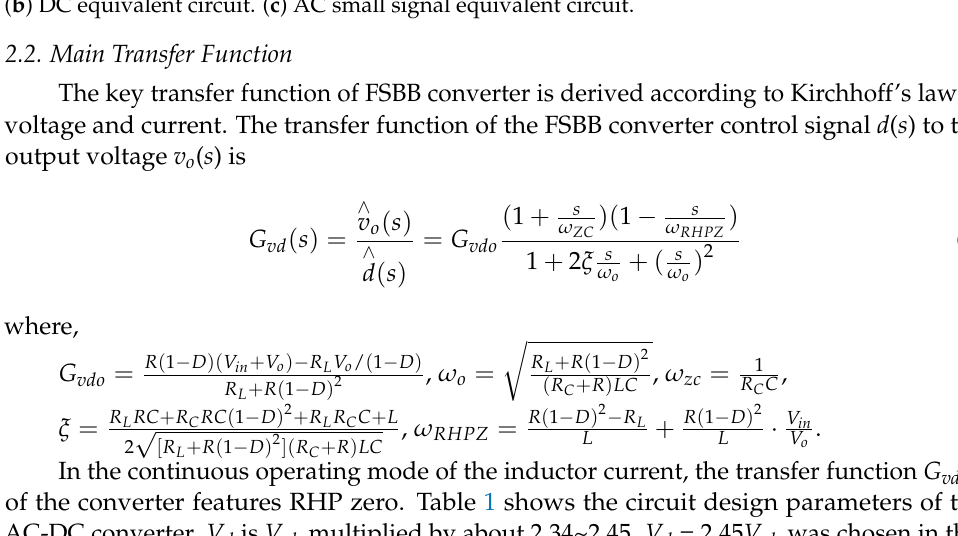
Figure 4. Non-ideal FSBB converter switching average circuit. ( a ) Equivalent controlled source circuit. ( b ) DC equivalent circuit. ( c ) AC small signal equivalent circuit.